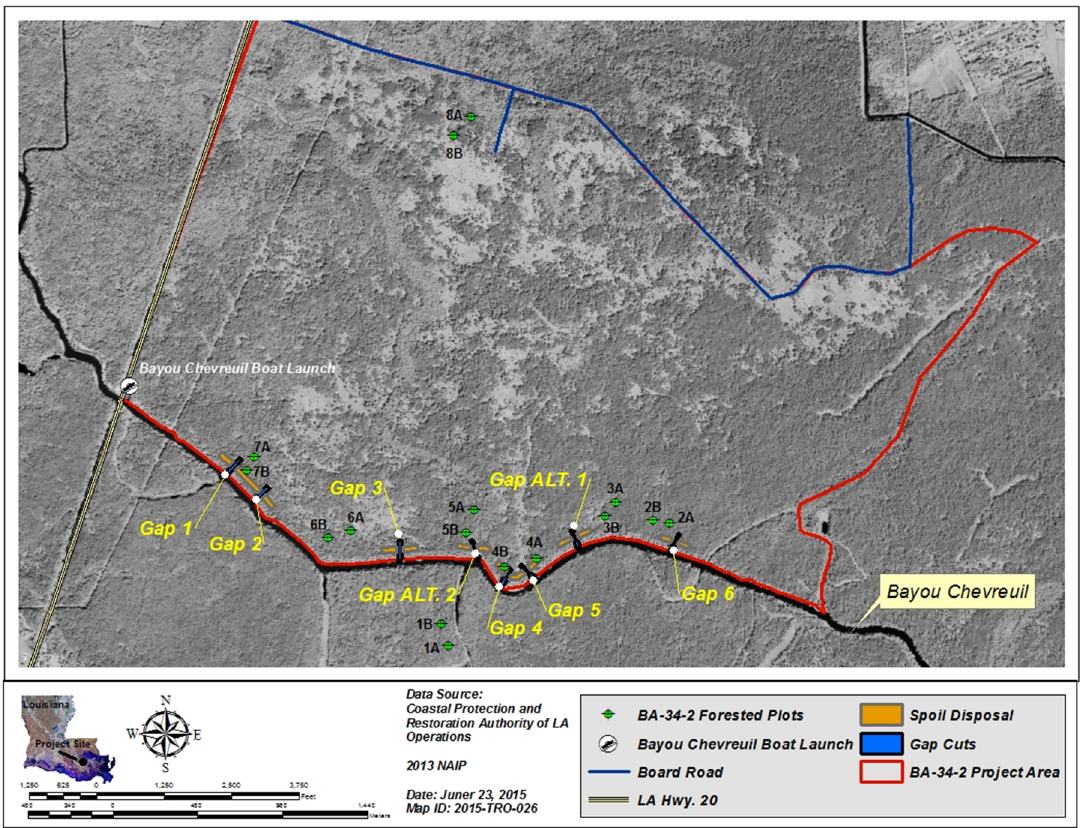
Figure 1. Aerial map showing the location of the sixteen 625 m 2 Stations (eight Sites) established in 2016 at the Lac des Allemands swamp restoration project. Locations of the eight gaps are also shown.